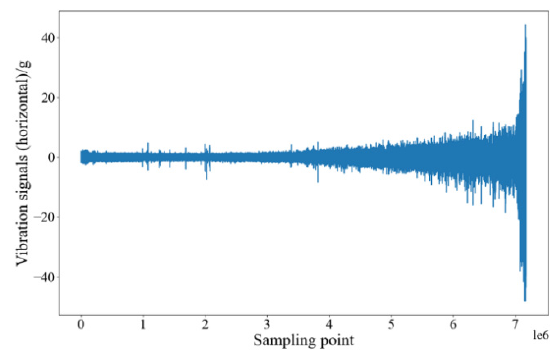
Figure 4. Raw Data of Bearing1_1.